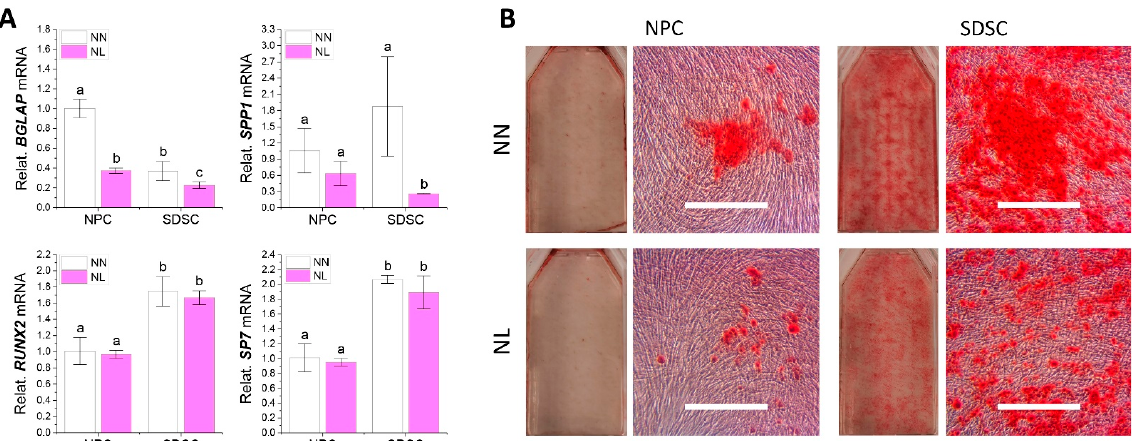
Figure 9. Evaluation of the effect of hypoxia on osteogenic differentiation of fetal MSCs. Normoxia expanded NPCs and SDSCs were incubated in osteogenic medium for 21 days in either normoxia (NN) or hypoxia (NL). RT-qPCR was used to assess expression of osteogenic marker genes ( BGLAP , RUNX2 , SPP1 , and SP7 ) ( A ), normalized against GAPDH levels as an internal control. Data ( n = 4) are represented in bar charts. Different letters indicate a statistically significant difference compared to the group within the same cell type ( p < 0.05). Matrix mineralization was evaluated using Alizarin Red S (ARS) staining for calcium deposition ( B ).